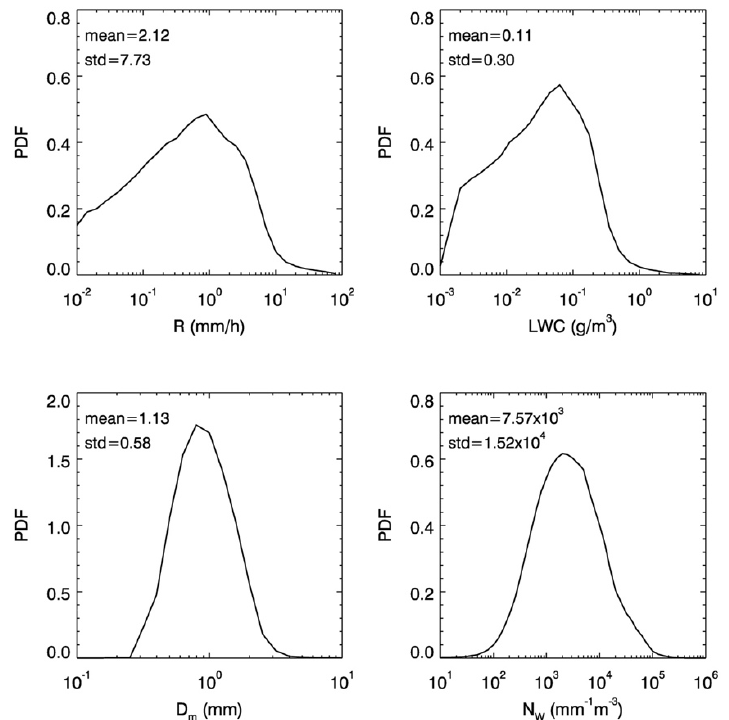
Figure 2. Probability density functions (PDF) of rainfall rate (R), liquid water content (LWC), D m and N w from 213,465 one-minute DSD data. The means and standard deviations (std) are also provided in the plot.